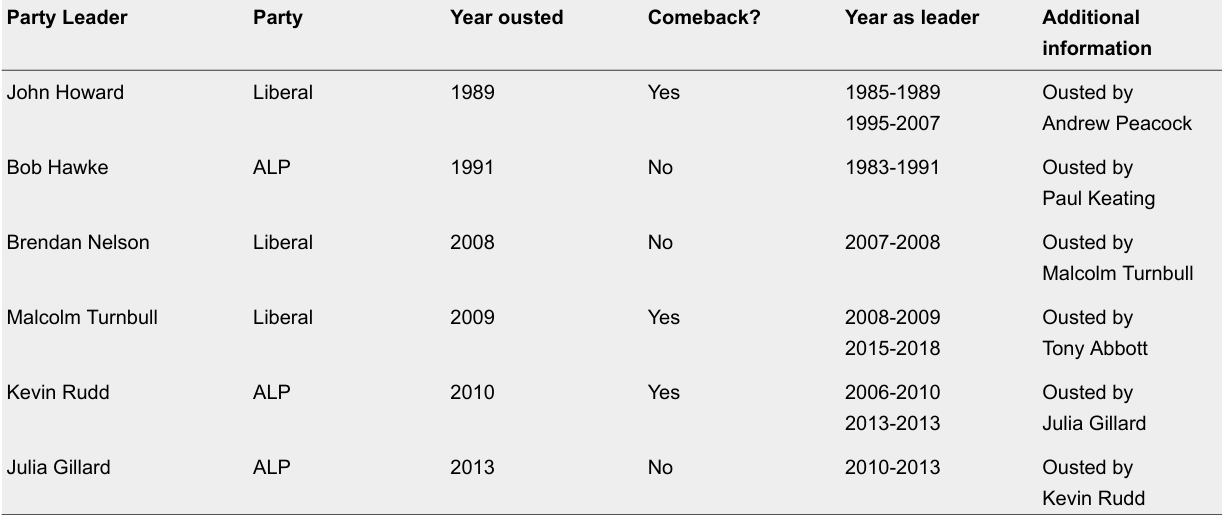
Ousted Party Leaders From the Two Major Political Parties in